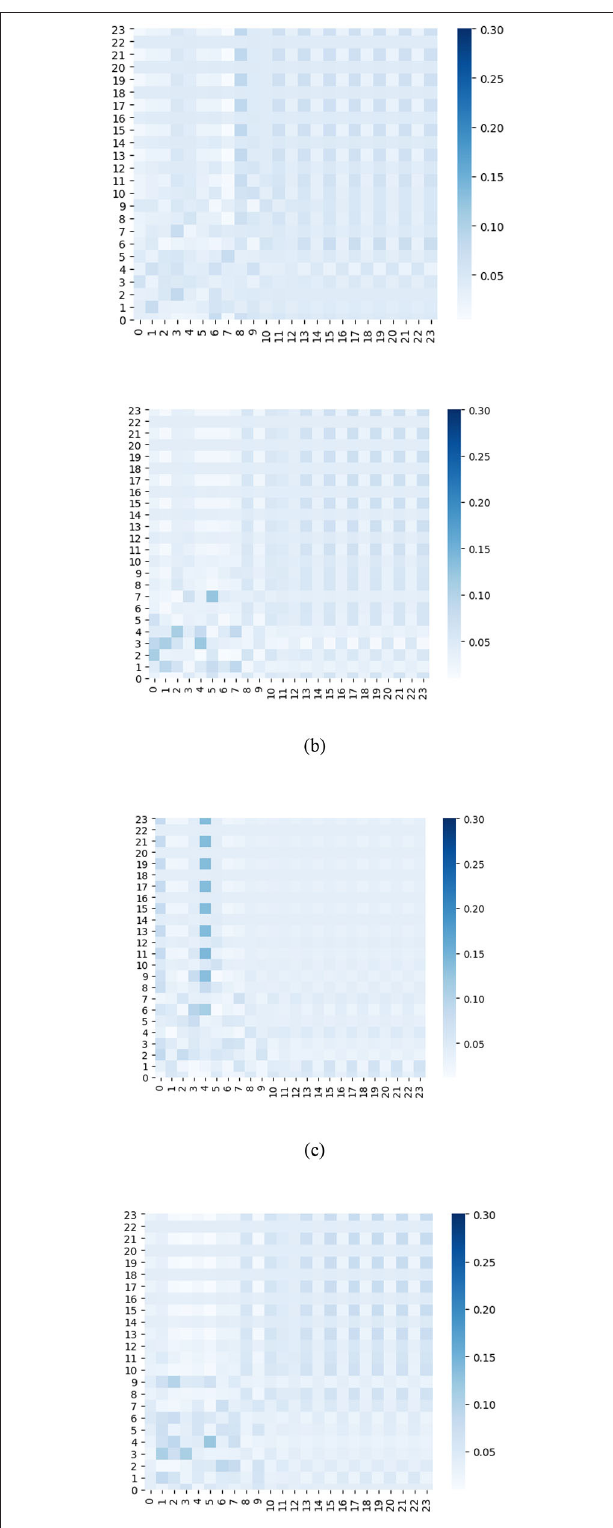
FIGURE 11 | Temporal sub-attention coefficients of time slices are visualized as heat